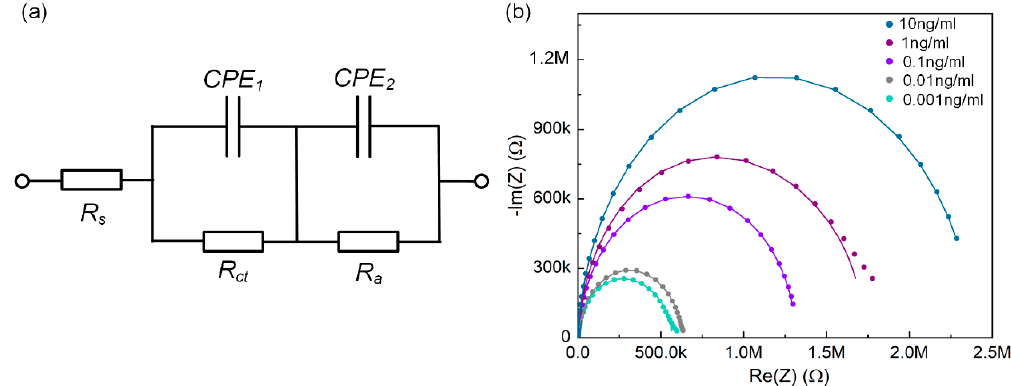
Figure 4. ( a ) the equivalent circuit model of the immune analysis in this paper; ( b ) Nyquist plots of actual measured and fitted values of impedance after incubation of different concentrations of IgG.